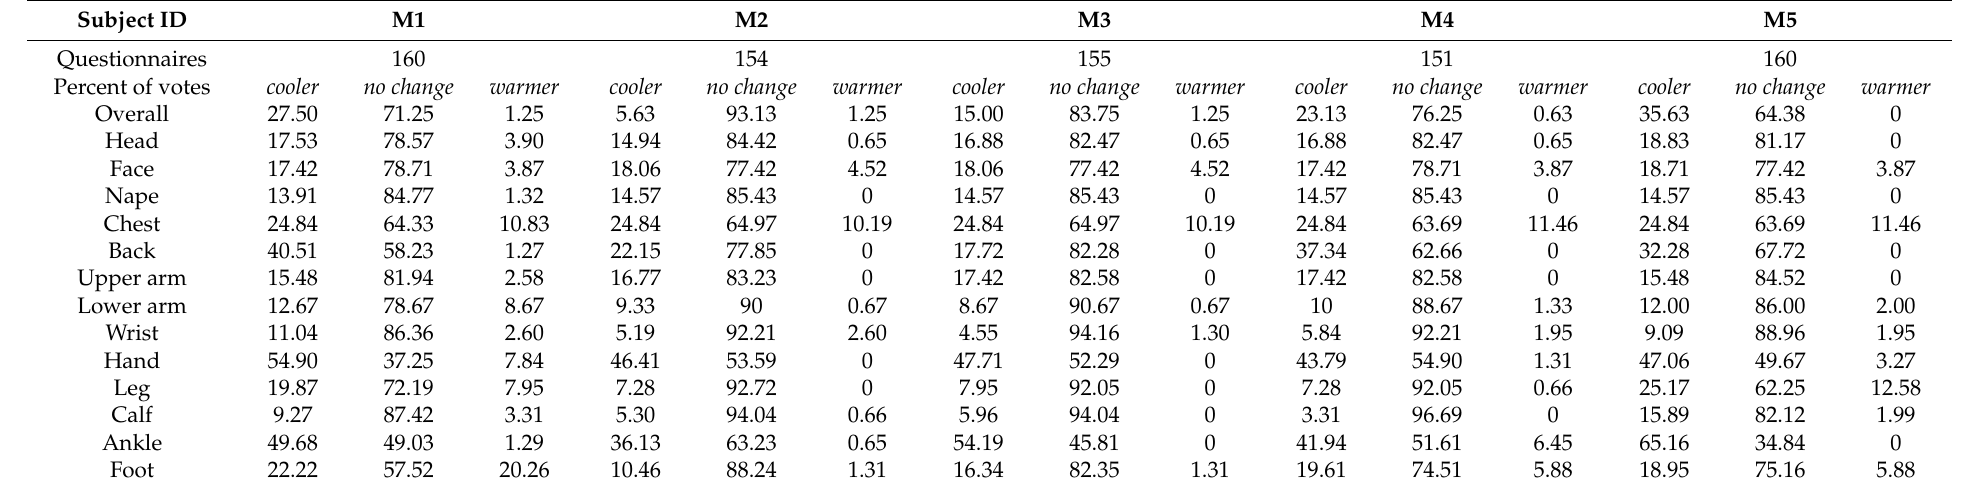
Table 2. A summary of votes for each